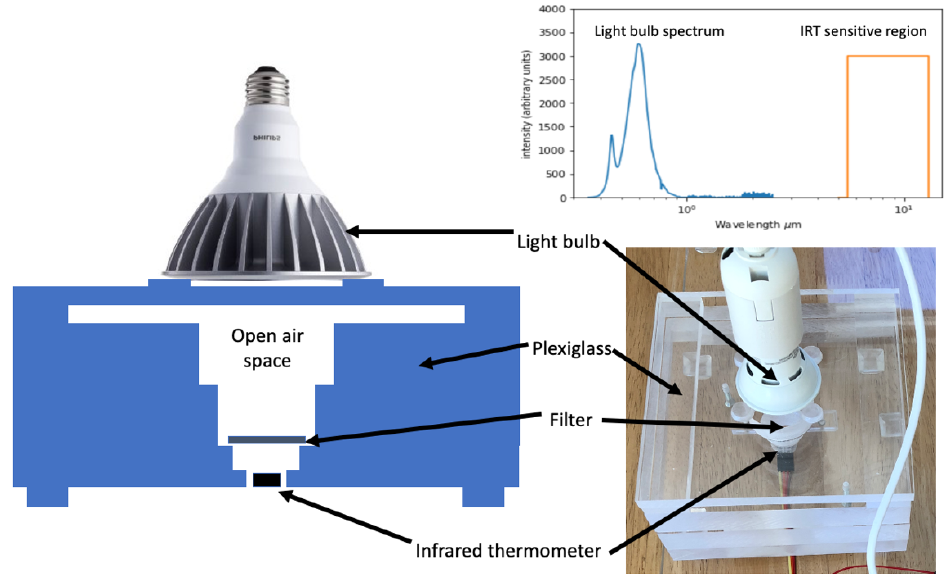
Figure 1. Schematic drawing and image of the LAHM instrument. The schematic view is a cross section through the instrument with blue representing the plexiglass sheets or transparent rubber feet (highest and lowest) to support the instrument or to support the lightbulb. The upper (wider) level of the open air space is not closed on the adjacent sides, which allows air warmed by the filter through conduction and convection to escape. The upper right plot shows the measured spectrum of the lightbulb compared to the IRT sensitivity.